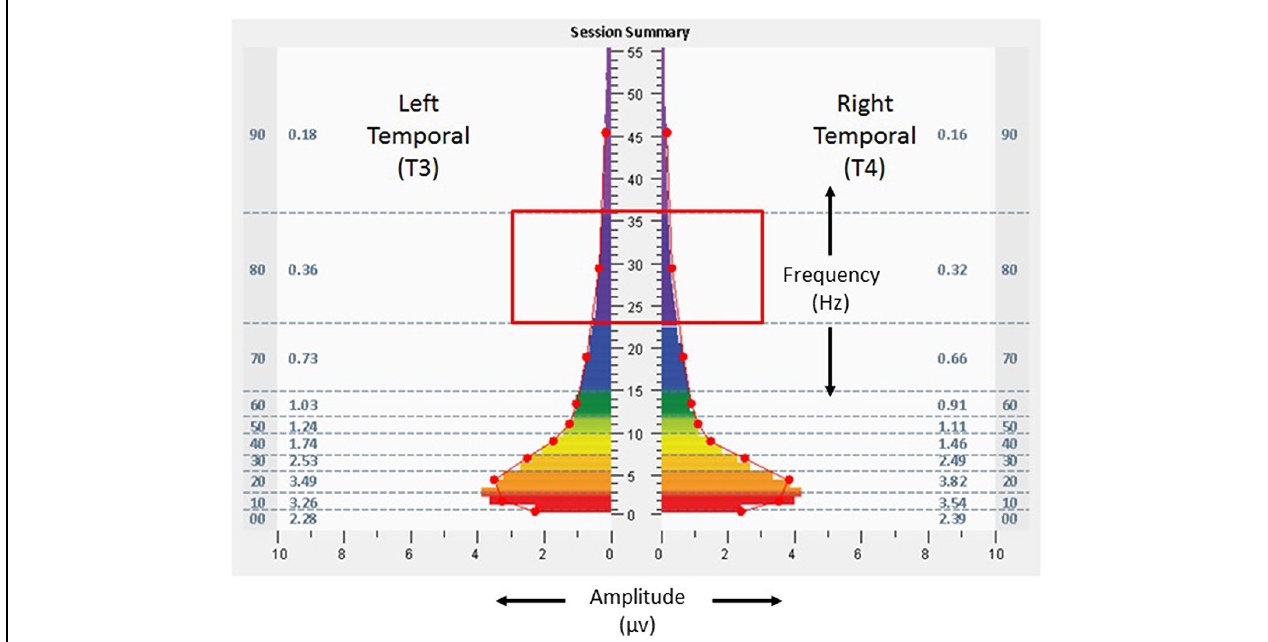
FIGURE 5 | Fast Fourier Transform spectral display of brain electrical activity observed during the penultimate minute of the penultimate allostatic technology session at the left and right temporal lobe (T3 left,